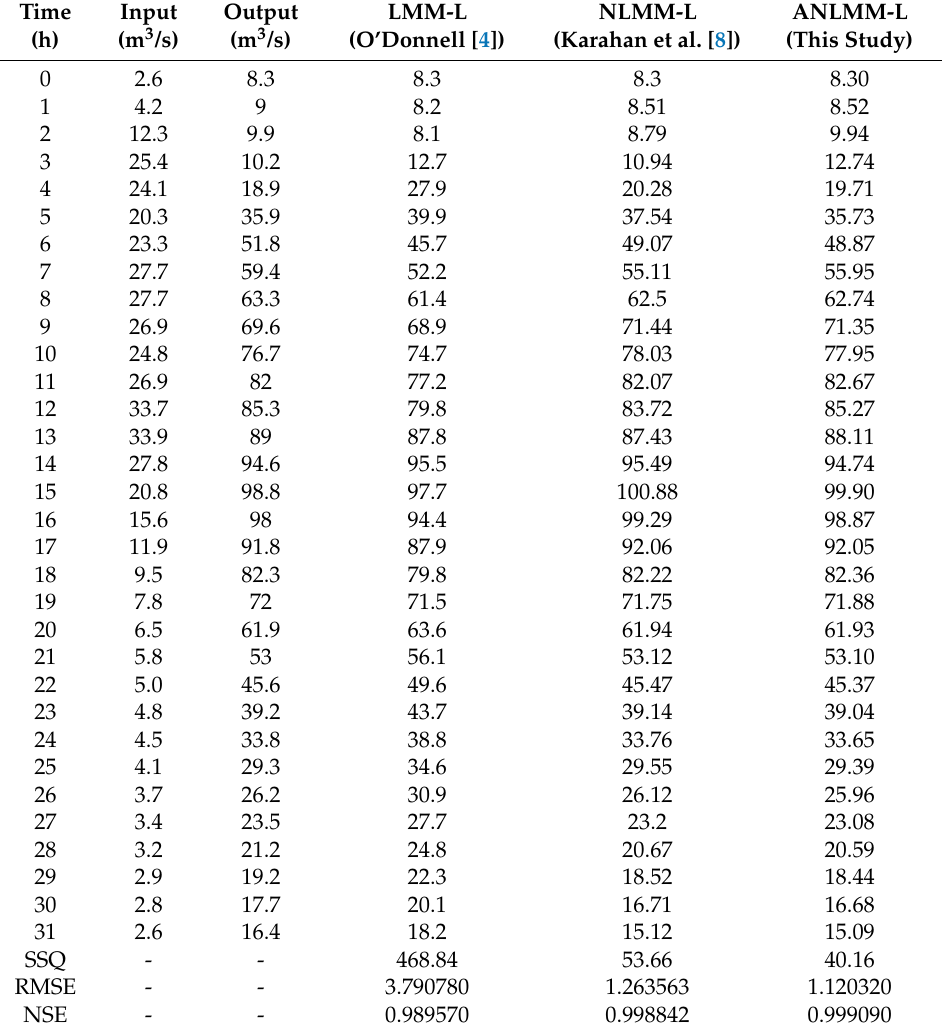
Table 8. Comparison of the outflow hydrographs calculated for the food data of River Wyre October in